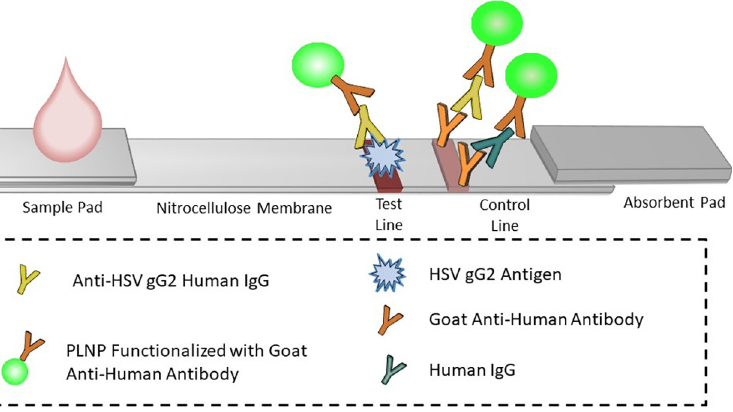
Fig 1. HSV-2 PLNP LFA schematic. A sample is diluted and then mixed with PLNPs functionalized with goat anti- human IgGs to form human IgG-PLNP complexes that were dispensed onto the sample pad of the LFA strip. The